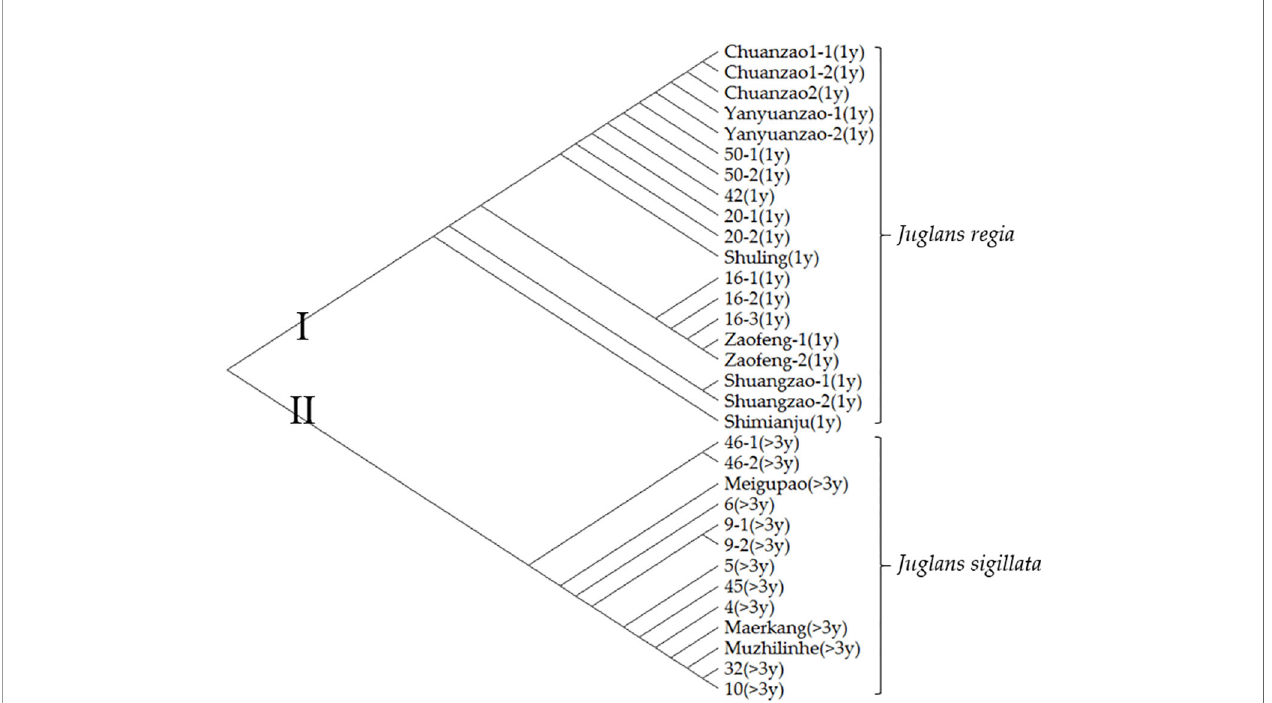
FIGURE 5 | Evolutionary analysis involving thirty-two early-fruiting nucleotide sequences from 22 walnut materials was performed with the maximum likelihood method. Evolutionary history was inferred by using the maximum likelihood method and the Tamura-Nei model. Evolutionary analyses were conducted in MEGA X. The information in parentheses represents the number of years after planting before fruiting occurs.